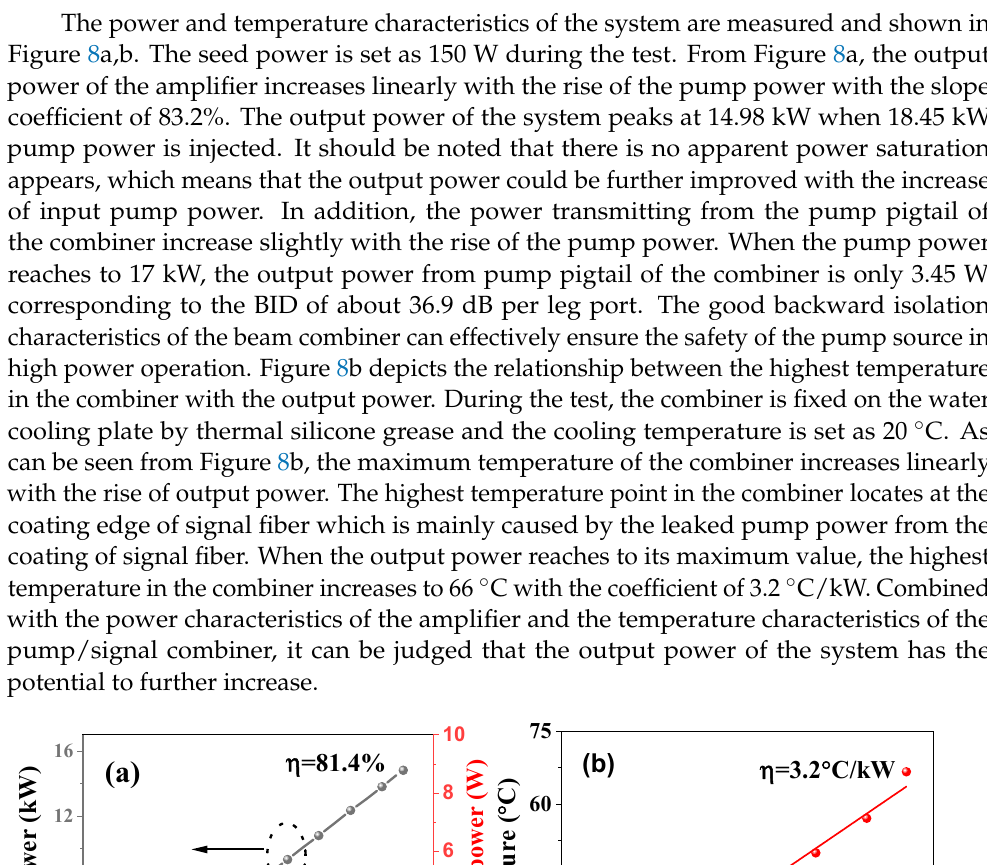
Figure 7. ( a ) Experimental setup of the counter-directional tamden-pumping fiber amplifier based on the home-made pump-signal combiner: CLS, cladding light stripper; HR, highly reflective mirror; DM, dichroic mirror; PM, power meter; OSA, optical spectrum analyzer; LQM, beam quality analyzer. ( b ) The measured refractive index profile of the gain fiber.